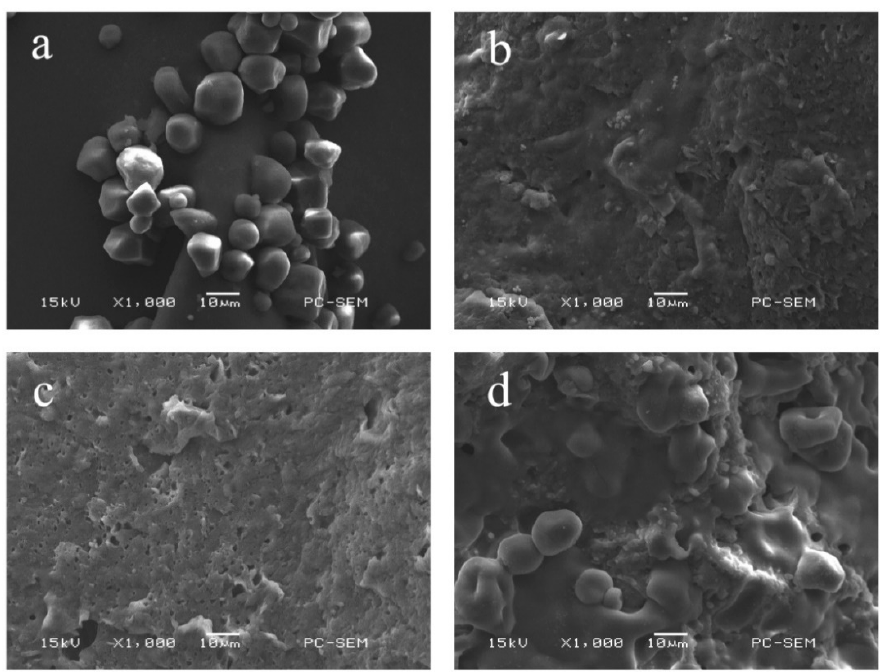
Figure 10. SEM images of the TPS/PBSA/PLA composites. ( a ) TPS; ( b ) 30% TPS/0% PLA/70% PBSA; ( c ) 30% TPS/10% PLA/60% PBSA; ( d ) 30% TPS/15% PLA/55% PBSA.